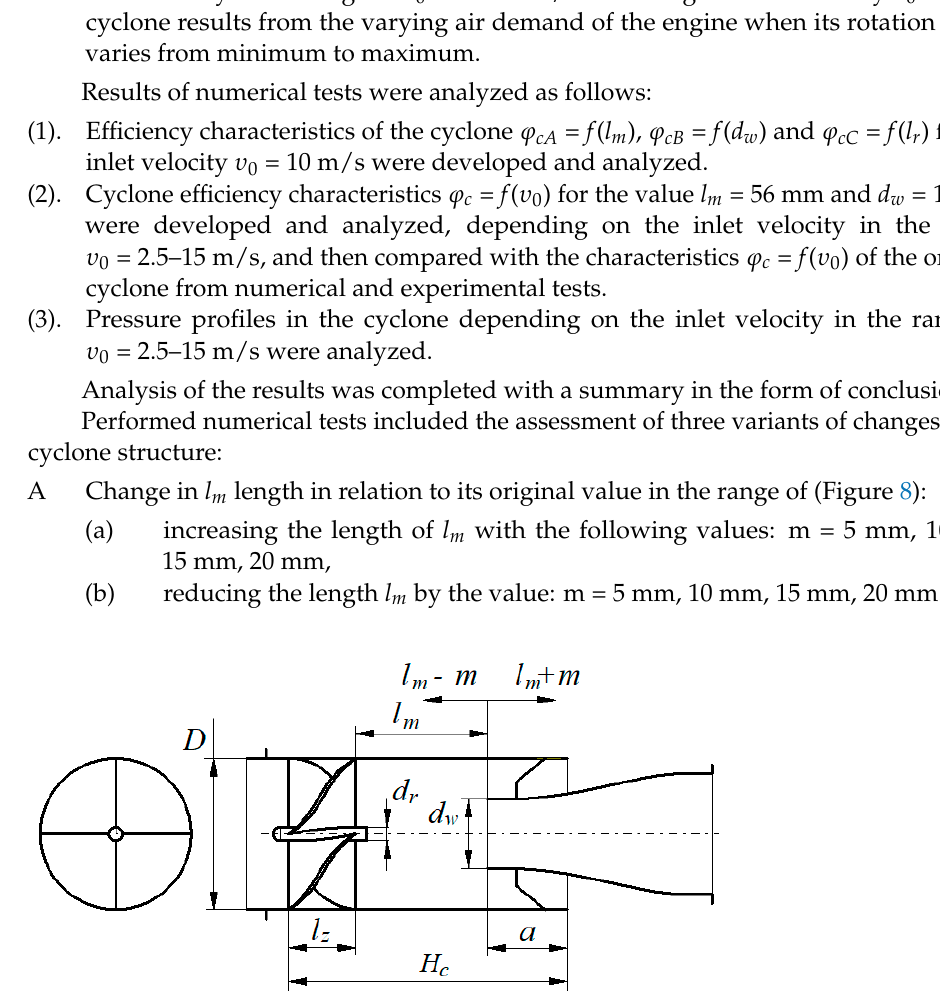
Figure 9. Diameter d w change of the cyclone outlet tube from its original value and applying the streamlined inlet shape of the outlet tube. C. Change in the core length by the value: r = 5, 10, 15 and 20 mm and ending it with a cone of angle α as shown in Figure 10.